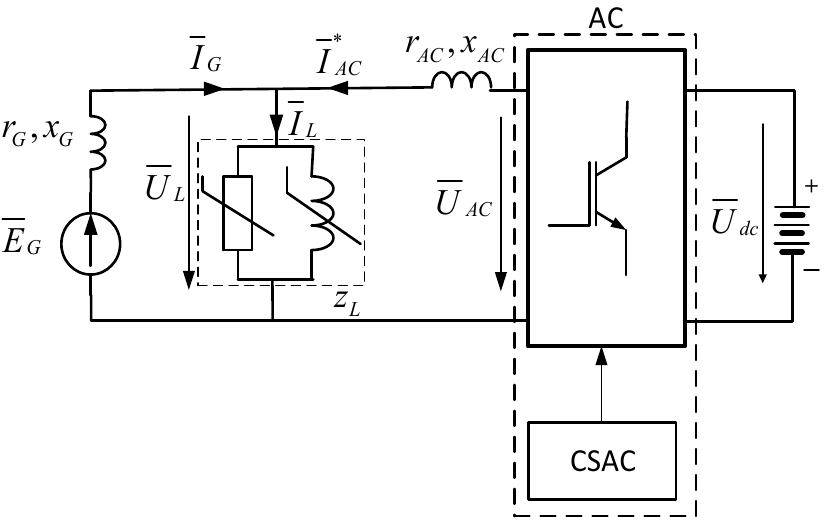
Figure 3. Equivalent circuit of a generator set with the PMSG.